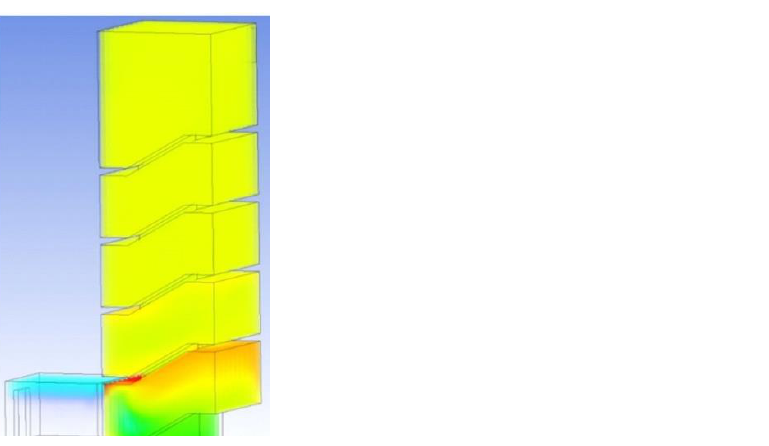
Figure 6. Carbon dioxide distribution 65 s after the door was opened. Carbon dioxide was measured as a mass fraction.